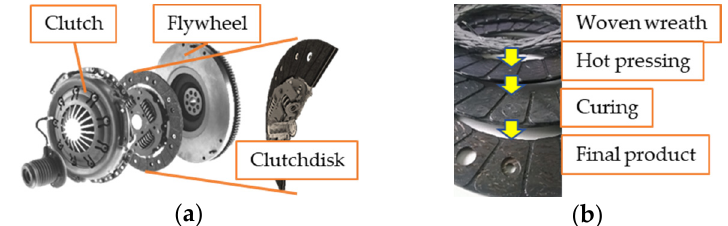
Figure 1. ( a ) Parts of a dry clutch system and cutout image of the dry-friction clutch disc; ( b ) products of phases of dry-friction clutch material production.